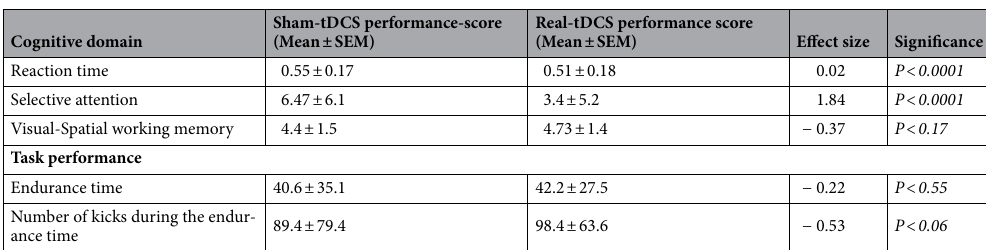
Table 2. Sham- vs. Real-tDCS effect sized and significance on cognitive performance and task related scores among participants.